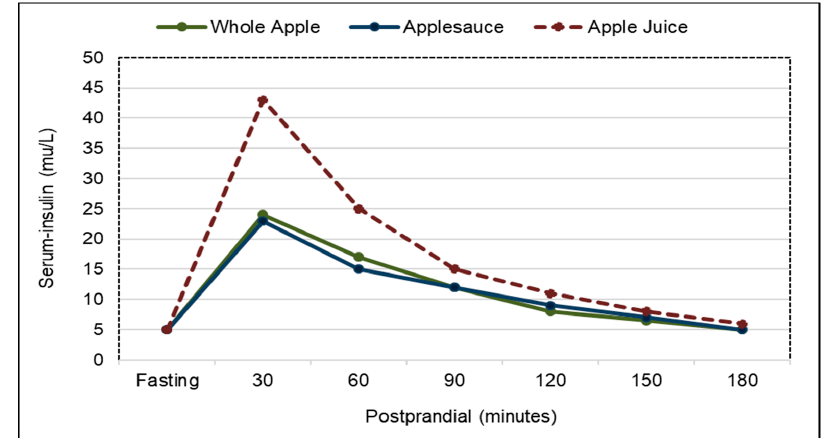
Figure 16. Mean postprandial serum insulin levels after eating whole apples, applesauce, and apple juice with serum insulin significantly increased for apple juice above whole apples and applesauce after 10 to 40 min ( p < 0.01]) [221].